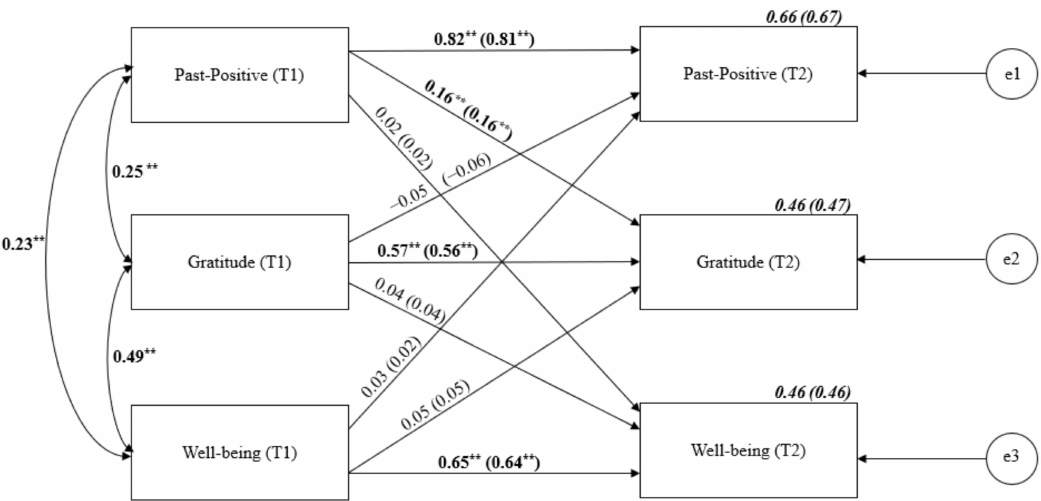
Figure 1. Cross-lagged panel analysis of Past-Positive TP, gratitude and well-being. Notes: Path entries are standardized estimates. T1 and T2 indicate the time when data were collected (Time 1 or Time 2, respectively). Estimates for the corresponding model with age and gender controlled are given in brackets. e1–e3 refers to the residual error or error variance that causes response variation in observed variables. ** p < 0.01.